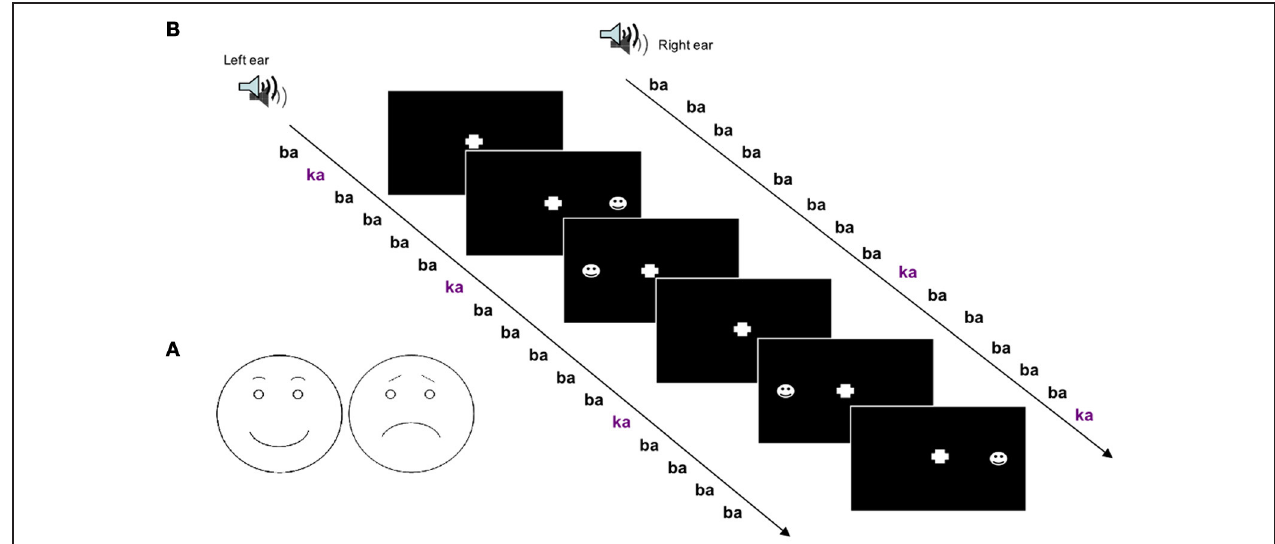
FIGURE 1 | (A) Schematicdrawingsoffaceswithpositiveandnegativevalencewereusedtoinvestigatecrossmodalattention-directingeffectsofauditorydeviants. (B) Experimental run; a dichotic oddball paradigm was applied to study crossmodal spatial cueing with acoustic deviants as cues and visual stimuli as targets.